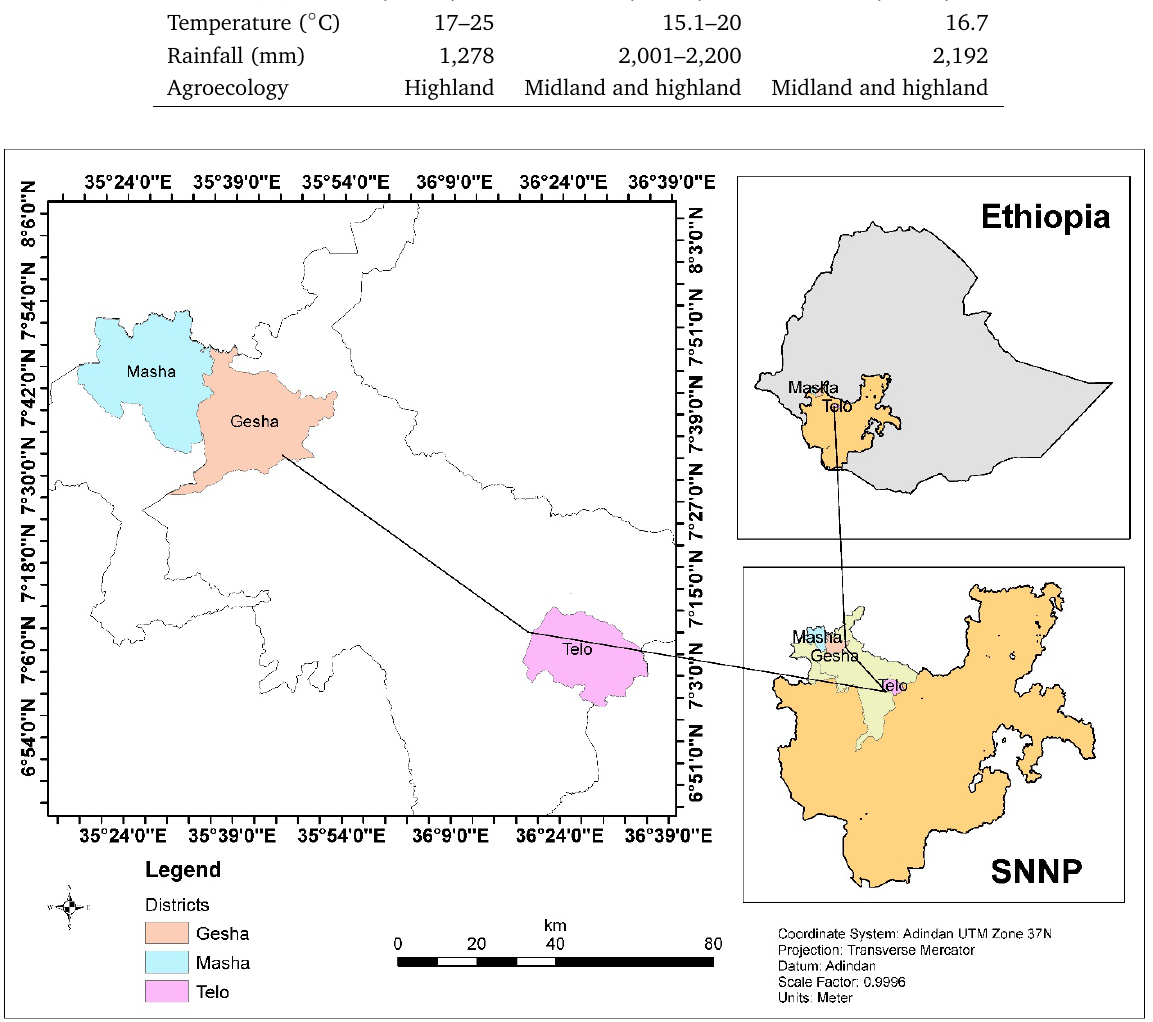
Figure 1. Map of the sampled locations and